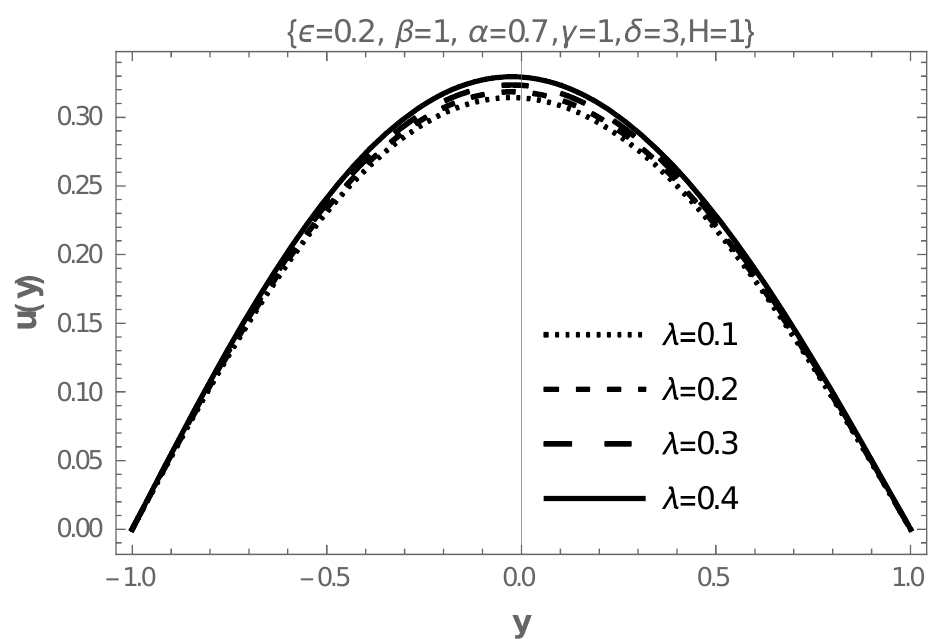
Figure 7. Temperature distribution with modified Hartman number ( H).